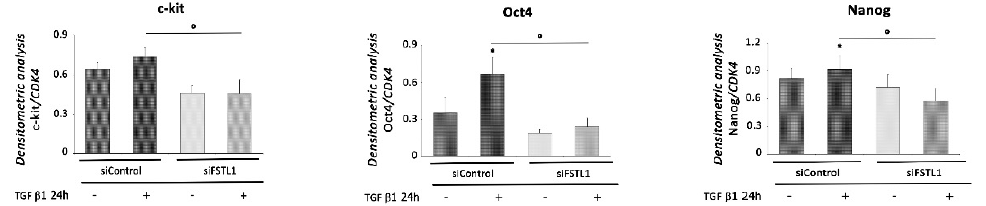
Figure 9. FSTL1 knockdown reverses EMT-associated and stem-like traits. ( A ) Representative images at 0, 12, 24, and 32 h after the scratch was made in EMCs transfected with siRNAs (siFSTL1 or siControl) for 72 h and treated or not with 1 ng/mL TGF β 1 for additional 48 h starting from the day after transfection. Scale bar: 100 µ m. ( B ) Quantification of migration distance, given as the percentage of wound healing calculated on the ratio between wound width at the observed time point and wound width at the 0 h time point ( n = 3; *, p < 0.05 vs. siControl; #, p < 0.05 vs. siControl + TGF β 1 48 h). ( C – E ) WB analysis performed with antibodies against ( C ) c-kit, ( D ) Oct4, and ( E ) Nanog. CDK4 was used as loading control. Upper panel: A representative Western blotting of three independent experiments is shown. Lower panel: Densitometric analysis of Western blot. Data are shown as means ± SEM. *, p < 0.05 vs. siControl, two-tailed Student’s t -test; ◦ , p < 0.05, two-way ANOVA, Bonferroni post hoc